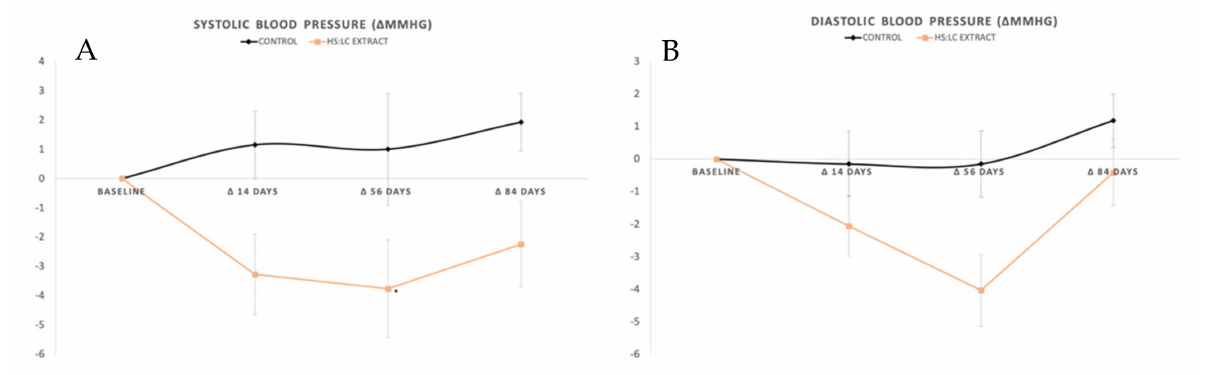
Figure 1. ( A ) Systolic blood pressure and ( B ) diastolic blood pressure determined using ambulatory blood pressure monitoring (ABPM). Represents statistically significant intragroup differences. Values are expressed by the increase (in mmHg) between the baseline and each control